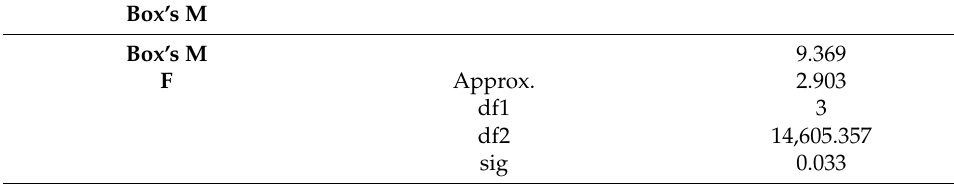
Tests null hypothesis of equal population covariance matrices.